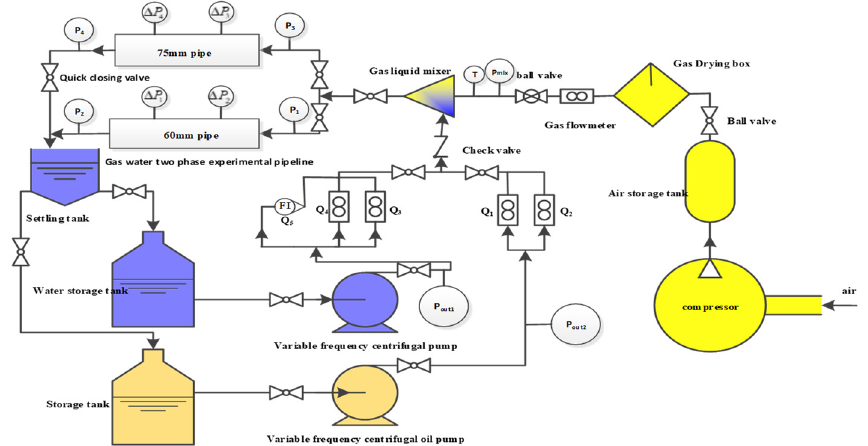
Figure 1. Schematic diagram of the experimental device.